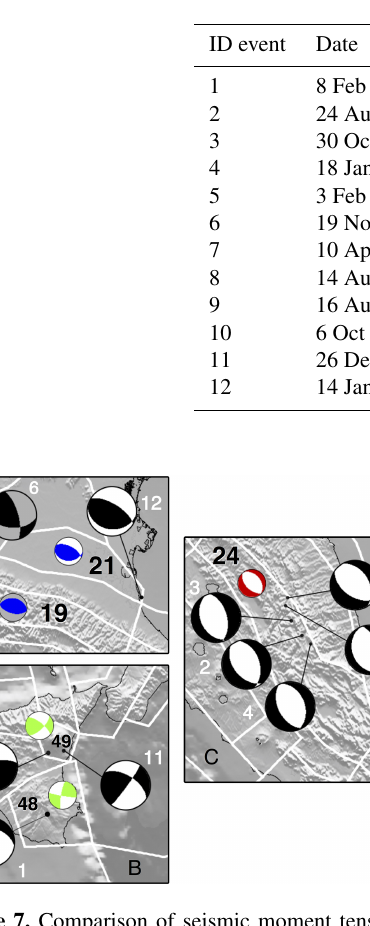
Figure 7. Comparison of seismic moment tensors of earthquakes that occurred after 2015 (in black, see Table 4) and the expected style of faulting identified in the same seismic zone (for colors see Fig. 6): (a) northern Apennines; (b) eastern Sicily; (c) central and southern Apennines. Focal mechanisms with a grey background are associated with deeper sources. Black numbers indicate the seismic zones, while white numbers refer to the seismic events listed in Ta- ble